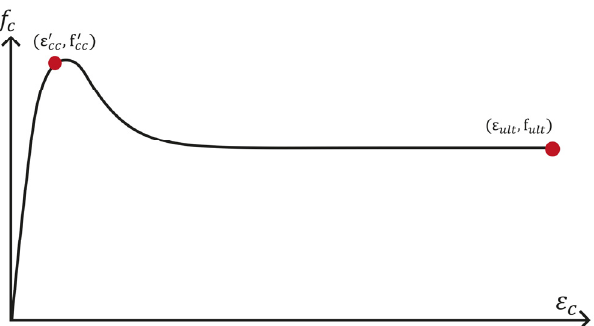
Figure 3. Schematic drawing of the axial stress-strain response of SMA-confined concrete.